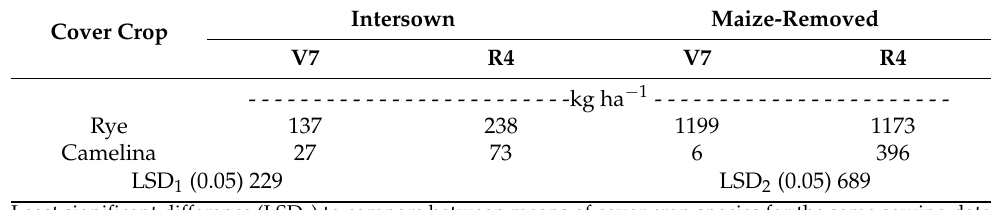
Table 7. Mean spring cover crop biomass prior to soybean planting for two cover crops sown at two maize growth stages (V7 and R4), and two maize removal treatments averaged across four environments at Casselton, Hickson, and Prosper, ND, USA, in 2019 and 2020. Cover Crop